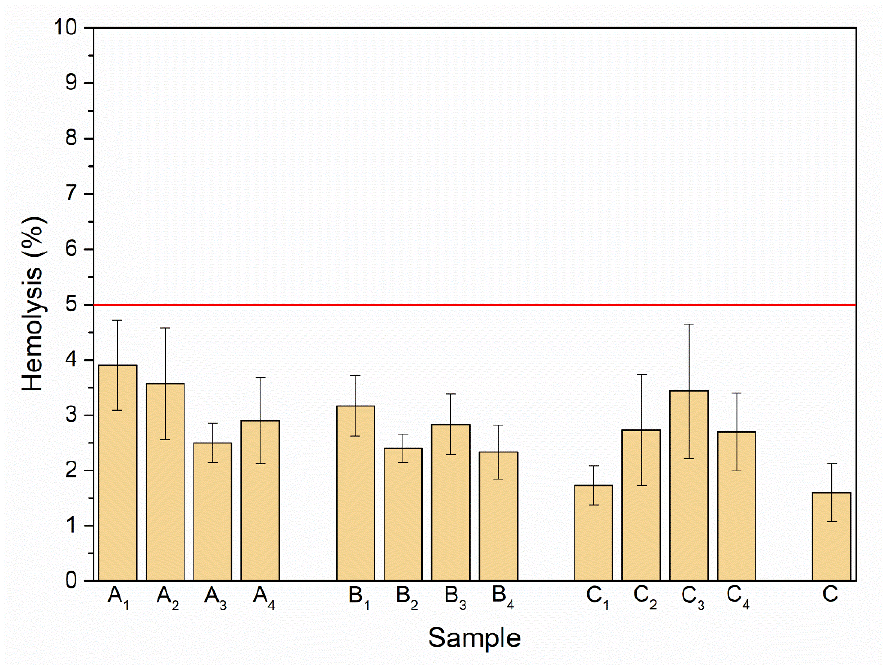
Figure 11. Effect of the nanoapatites (1 mg/mL): HAp (A 1 ), ClAp (B 1 ) and FAp (C 1 ) as well as nanoapatites doped with Li + (A 2 , B 2 , C 2 ), doped with Eu 3+ (A 3 , B 3 , C 3 ) and co-doped with Eu 3+ /Li + ions (A 4 , B 4 , C 4 ) on selective membrane permeability, i.e., hemolytic activity. Standard incubation conditions (PBS, 60 min, 37 ◦ C; degree of hemolysis lower than 5% corresponding to a lack of hemolytic activity—red line), mean values ± SD, n = 9,